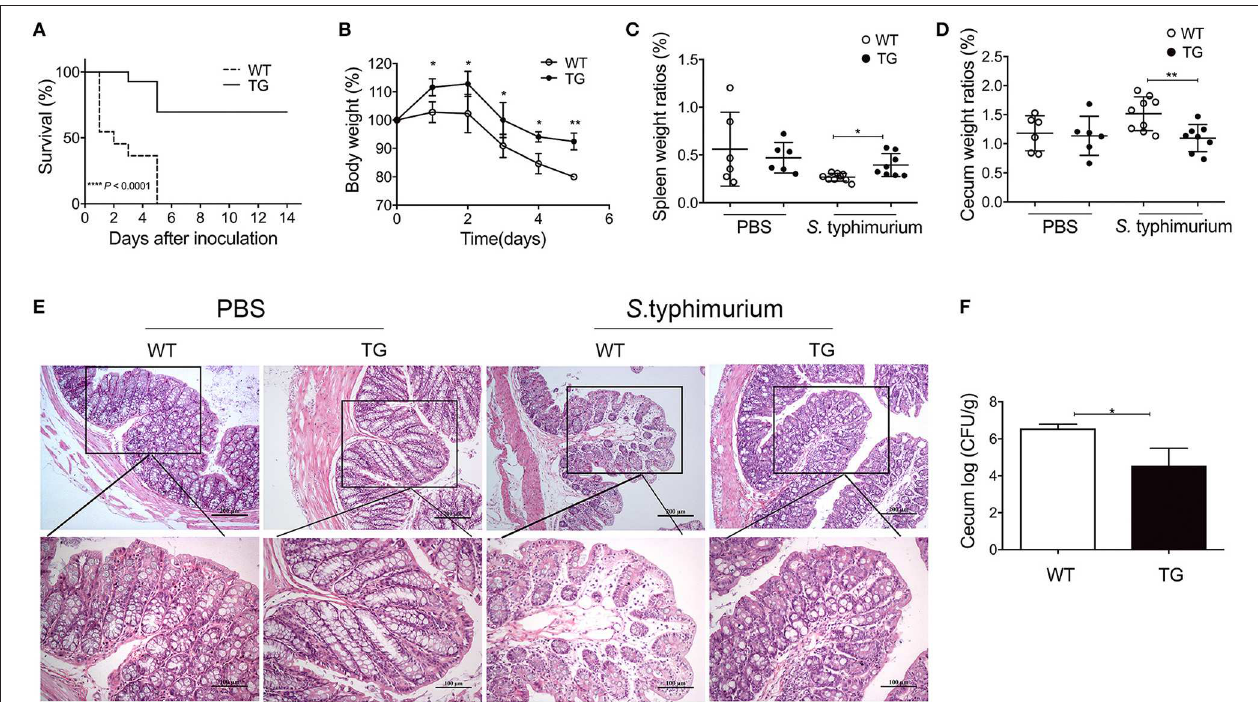
FIGURE 2 | PBD-2 overexpression protected mice from S. Typhimurium infection. (A) Survival rates of WT and TG mice after infection of S. Typhimurium. WT and TG mice were orally infected with 5 × 10 8 CFU of S. Typhimurium ( n = 10). The survival numbers of mice were recorded daily. (B–F) WT and TG mice were orally infected with S. Typhimurium at 2.5 × 10 8 CFU ( n ≥ 6). (B) Comparison of percentages of body weight loss (currently body weight/original body weight before infection) between TG mice and WT mice daily ( n = 7 in each group). (C) Comparison of spleen weight ratios (organ weight/body weight) between TG and WT mice at 24h post-infection (WT, n = 9; TG, n = 8). (D) Comparison of caecum weight ratios (organ weight/body weight) between TG and WT mice at 24h post-infection (WT, n = 9; TG, n = 8). (E) Comparison of pathological changes of caecum between TG and WT mice at 24h post-infection. Results are shown as the histological sections of ceca after H&E staining. Upper panel, magnification = 100-fold; lower panel, magnification = 200-fold. (F) Comparison of bacterial loads in the ceca between TG and WT mice at 24h post-infection ( n = 6). Mice treated with PBS were used as negative control ( n = 6). Data are represented as means ± SD. * p < 0.05, ** p < 0.01.